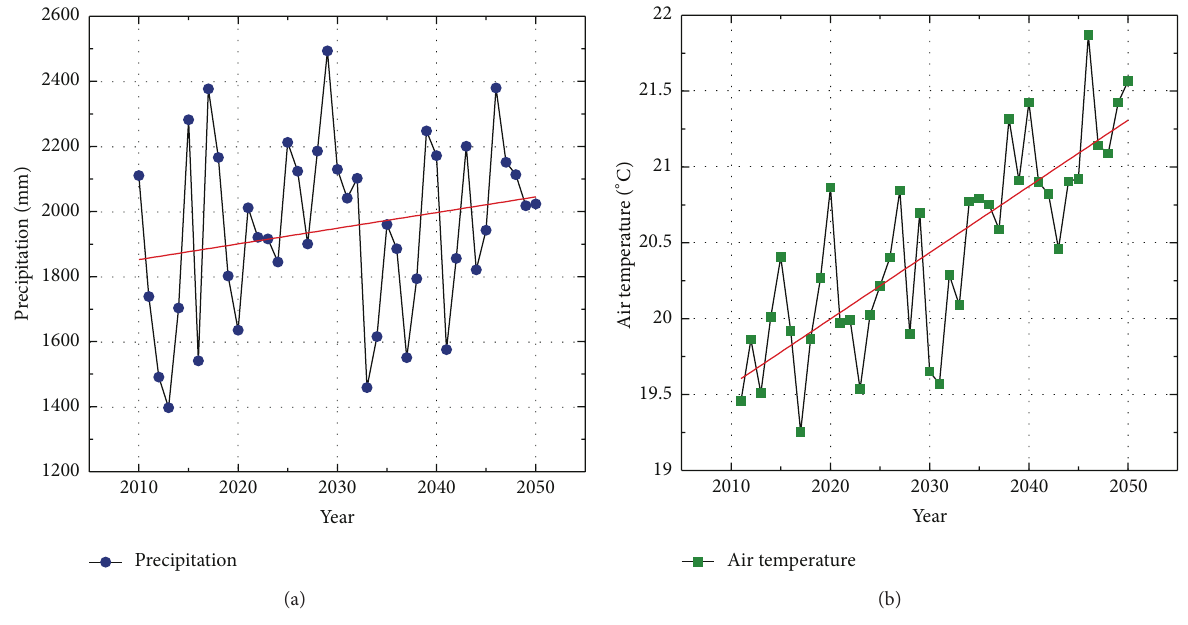
Figure 4: Interannual change of precipitation and air temperature in the next 40 years under A2a